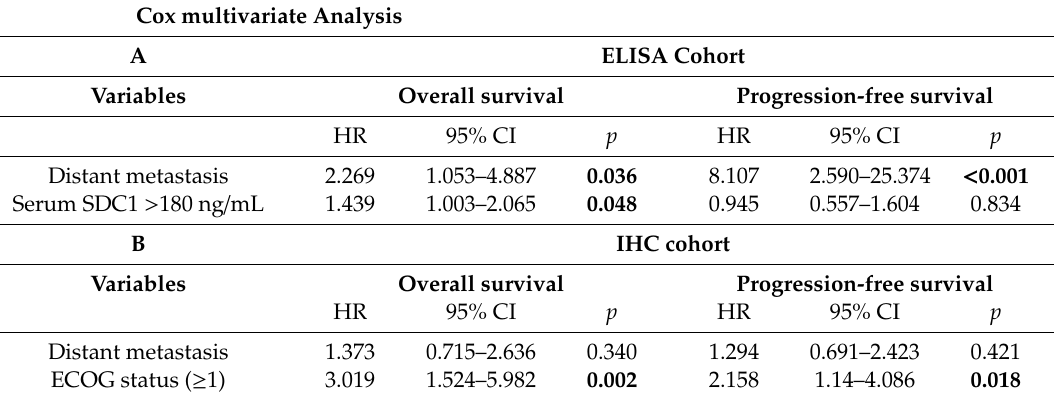
Table 4. Cox multivariate OS and PFS analysis in the ELISA ( A —serum SDC1 concentration) and IHC Oncology Group. Bold printed p -values were significant ( <